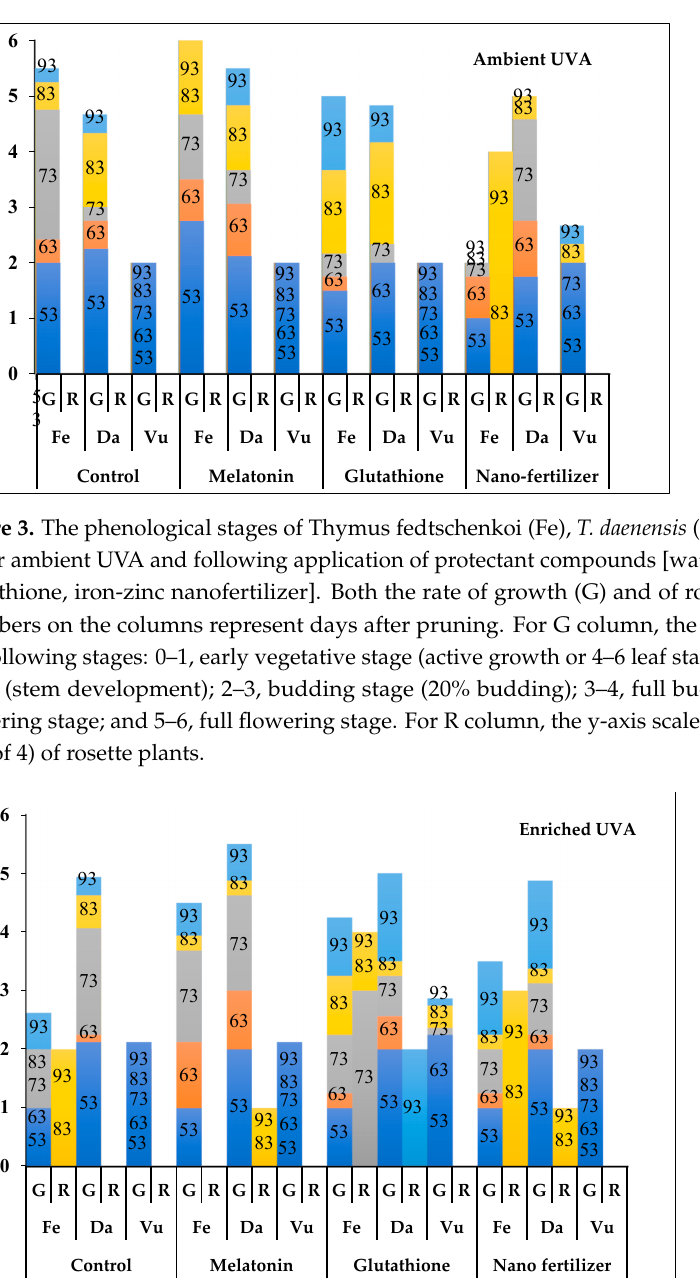
plants; for T. fedtschenkoi (see Figure 1). These phenotypes were also recorded, and data alongside to the growth column (Figures 3–5). The y-axis scale for this separate column are depicted in a separate column alongside to the growth column (Figures 3–5). The represents the number (out of 4) of compact plants. y-axis scale for this separate column represents the number (out of 4) of compact plants.